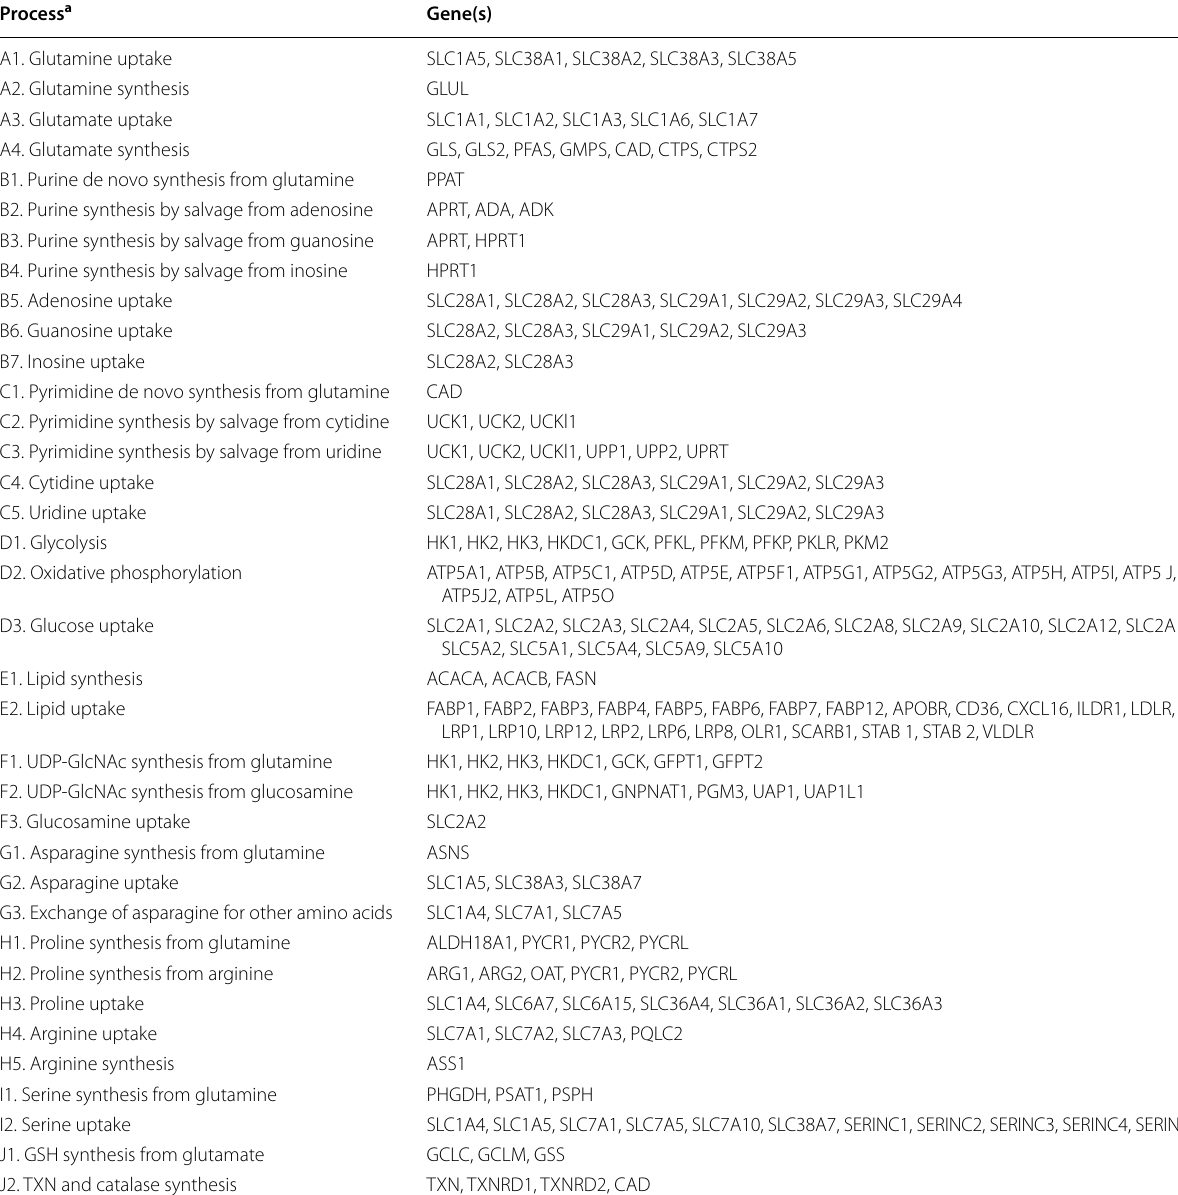
Table 2 Genes involved in biological processes related to metabolisms of glutamine and